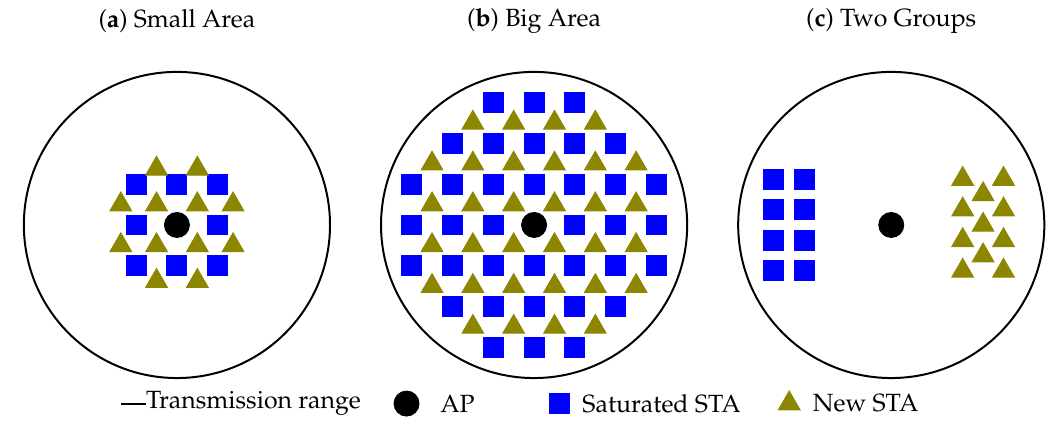
Figure 4. Studied